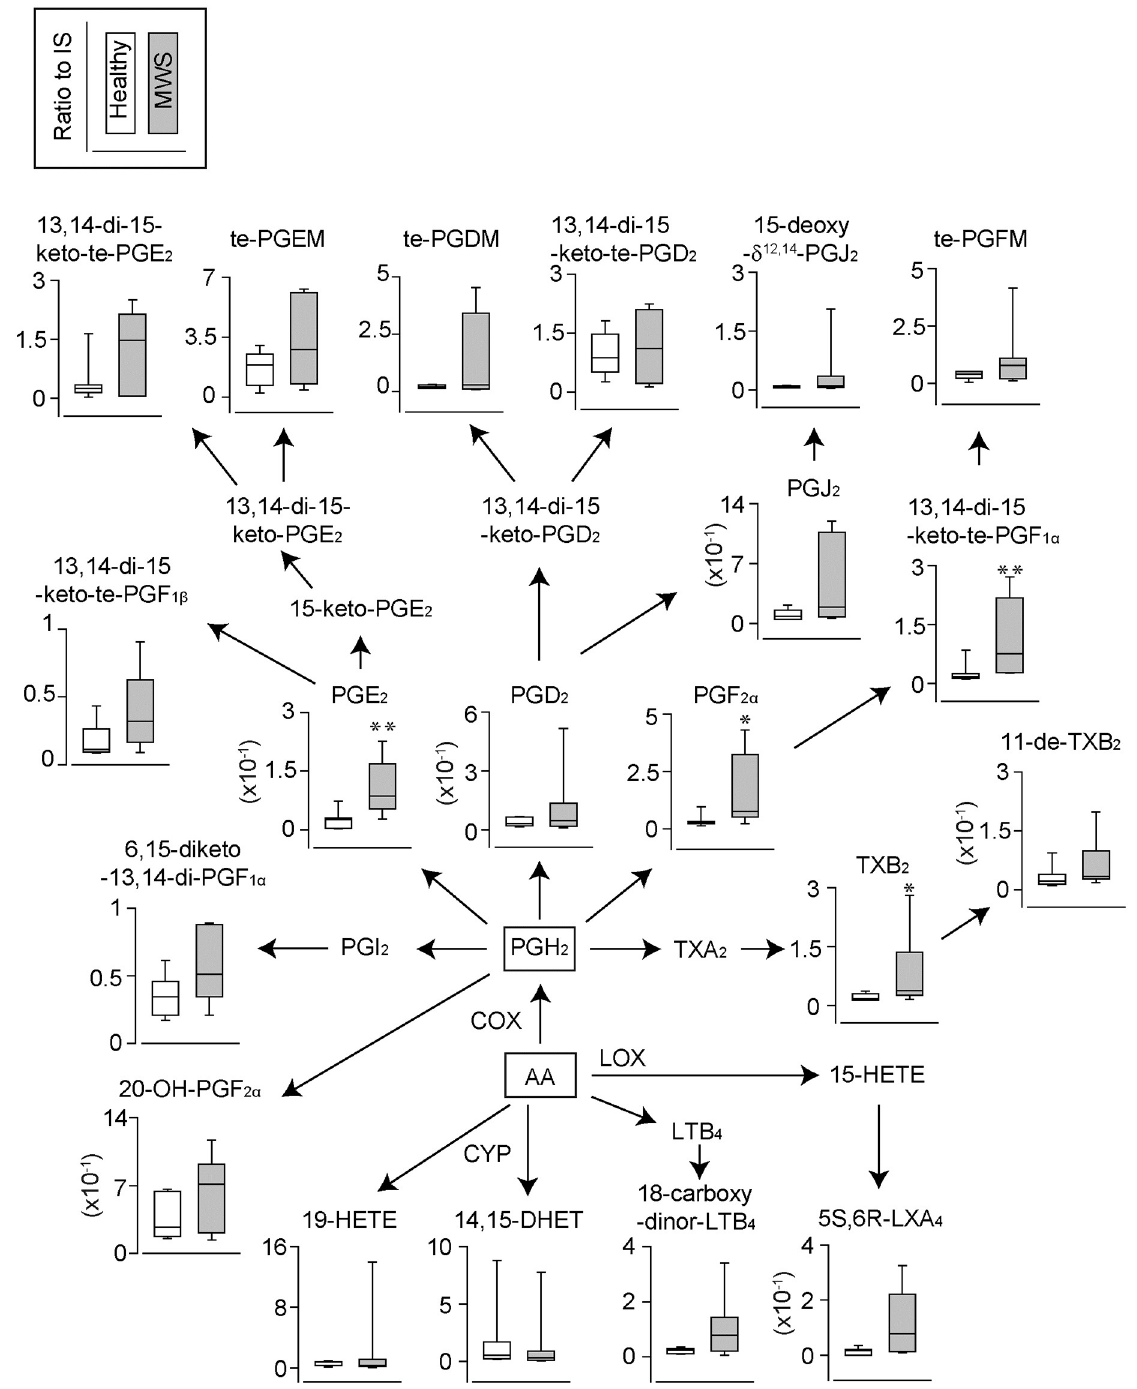
Fig 2. The urinary levels of AA-derived enzymic-oxidative metabolites. The urinary levels of arachidonic acid (AA)-derived catalyzed metabolites in healthy marmoset (N = 7) and marmosets with MWS (N = 7). di. dihydro; te, tetranor; COX, Cyclooxygenase; CYP, cytochrome P450 epoxygenase; LOX, lipoxygenase. � p < 0.05, �� p < 0.01 compared to healthy urines.